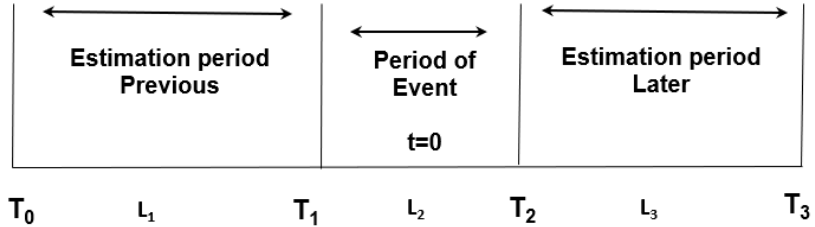
Figure 4. Event study